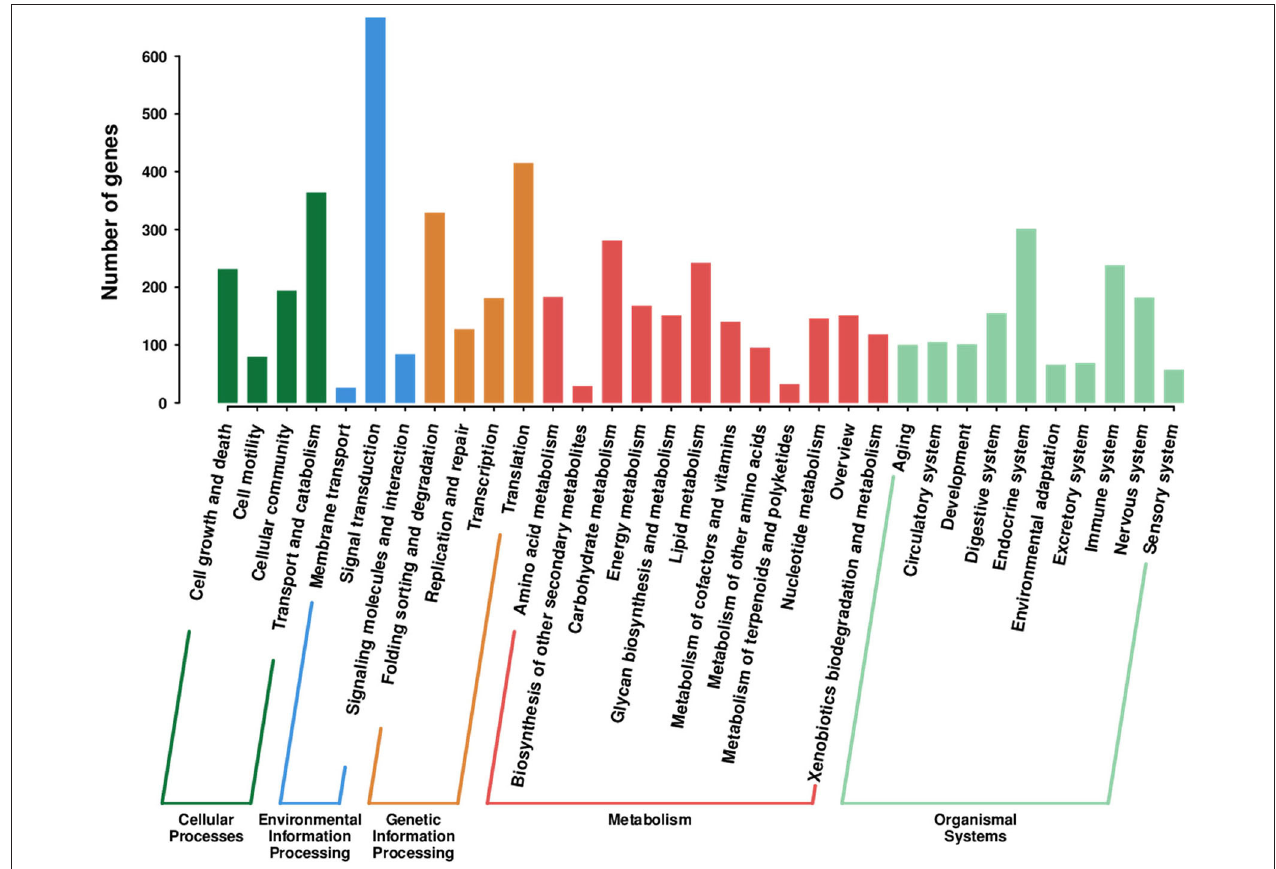
FIGURE 6 | KEGG classifications of unigenes of M. aurolineatus .